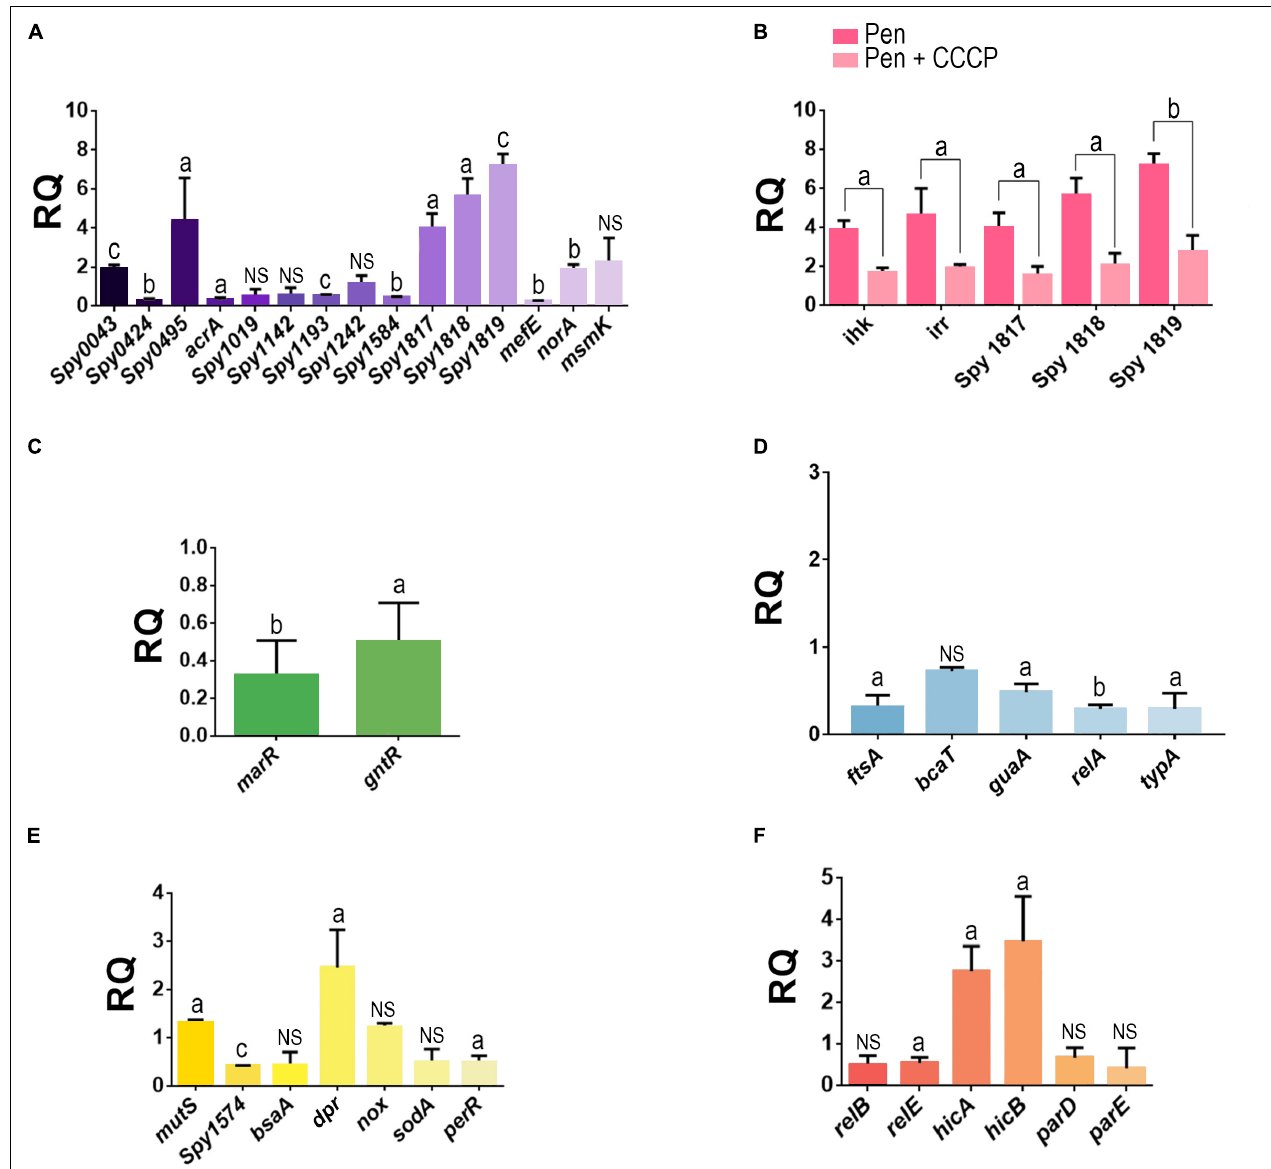
FIGURE 5 | Analysis of the gene expression in penicillin-persister cells of the Streptococcus pyogenes strain 37–97. (A) Transcript levels of genes associated with efflux pumps in penicillin persisters. (B) Influence of CCCP in the expression of genes associated with ABC-type efflux pump (Locus_tag: MGAS10750_Spy1817 , MGAS10750_Spy1818 , and MGAS10750_Spy1819 ) and ihk/irr regulators in penicillin persisters. (C) Transcript levels of genes associated with negative transcriptional regulators of efflux pump in penicillin persisters. (D) Transcript levels of genes associated with protein biosynthesis and cell growth in penicillin-persisters. (E) Transcript levels of genes associated with stress conditions in penicillin-persisters. (F) Transcripts levels of genes associated with toxin-antitoxin (TA) systems in penicillin-persisters. Gene locus tags annotated in the genome of the strain MGAS10750 (Acc: NC_008024) were used as a reference sequences for primer design. Student’s t -test was applied. a p < 0.05, b p < 0.01, c p < 0.001. For all gene expression assays, the respective calibrator sample (susceptible cells) was assigned relative quantification equal 1. For all tests, JZS Bayes factor agrees with Student’s t -test, except for the gene locus MGAS10750_ S py1019 for which the Bayes Factor (BF = 1.042144) was in favor of the alternative hypothesis, bsaA (BF = 1.289759, in favor of alternative hypothesis), sodA (BF = 1.213086, in favor of the alternative hypothesis), and relB (BF = 1.349216, in favor of the alternative hypothesis). RQ, Relative